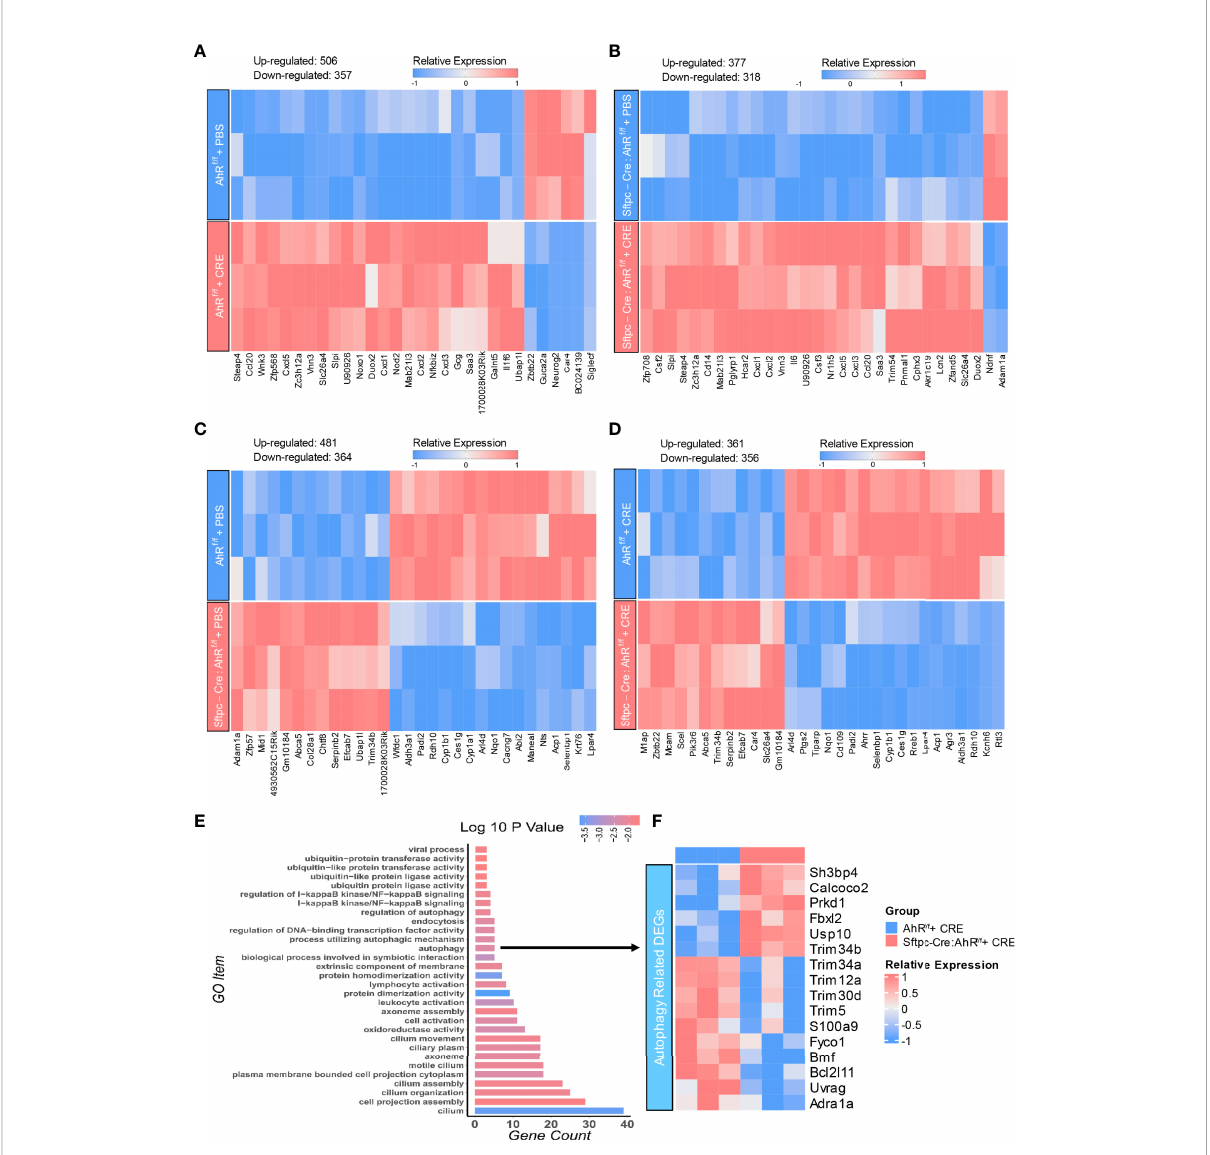
FIGURE 7 AhR-regulated transcriptional pro fi les in AT2 cells. (A, B) Heatmap of differentially expressed mRNAs in AT2 cells of AhR f/f (A) or Sftpc-cre;AhR f/f (B) mice treated with PBS verses cockroach allergen (CRE, 50 µg/ml) for 24 h (C, D) Heatmap of differentially expressed mRNAs in AT2 cells of AhR f/f verses Sftpc-cre;AhR f/f mice treated with PBS (C) or cockroach allergen CRE, 50 µg/ml) (D) for 24 h n = 3 per group (A – D) . (E) Gene Ontology (GO) functional enrichment analysis of the differentially expressed genes in (D) . (F) Heatmap of differentially expressed genes (DEG) that are involved in cellular